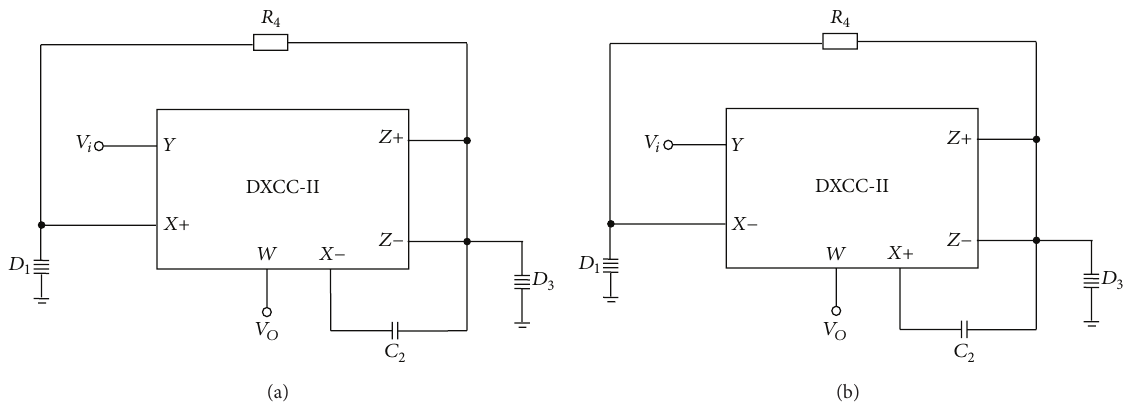
Figure 4: (a) Proposed second-order all-pass filter using frequency transformation. (b) Another circuit obtained by interchanging 𝑋 ports.